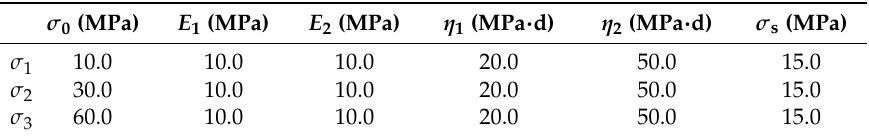
Table 5. Parameters of Nishihara model.